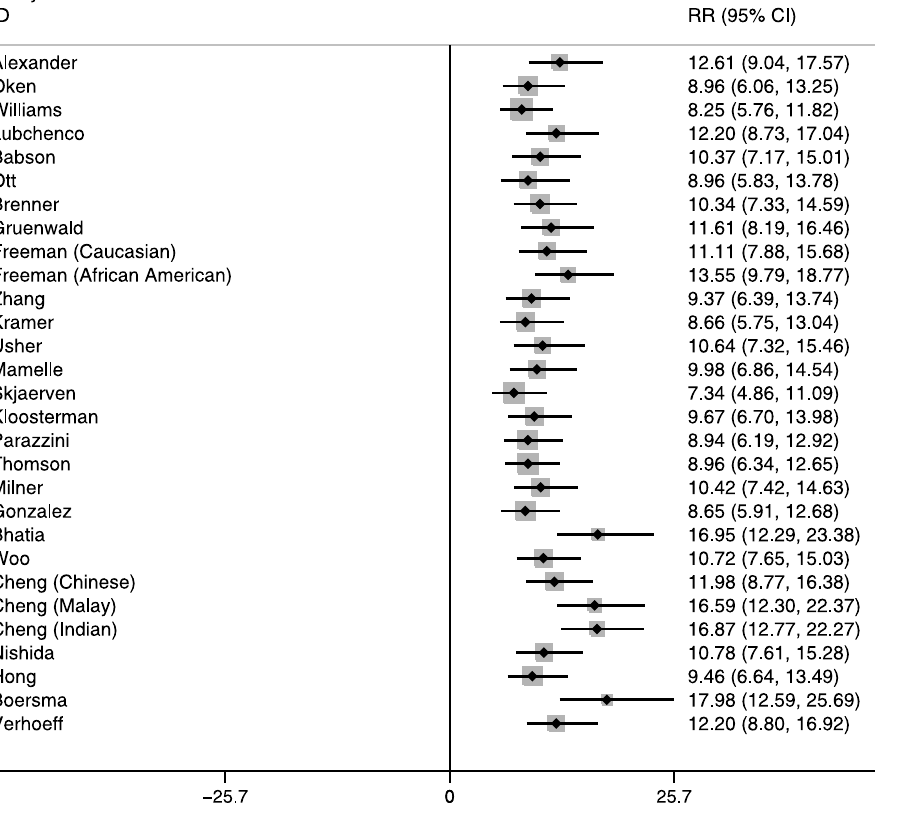
Figure 3. Risk ratios for Preterm-Small-for-Gestational-Age, Neonatal Mortality: Southern Nepal (reference: Term-Appropriate-for- Gestational-Age).